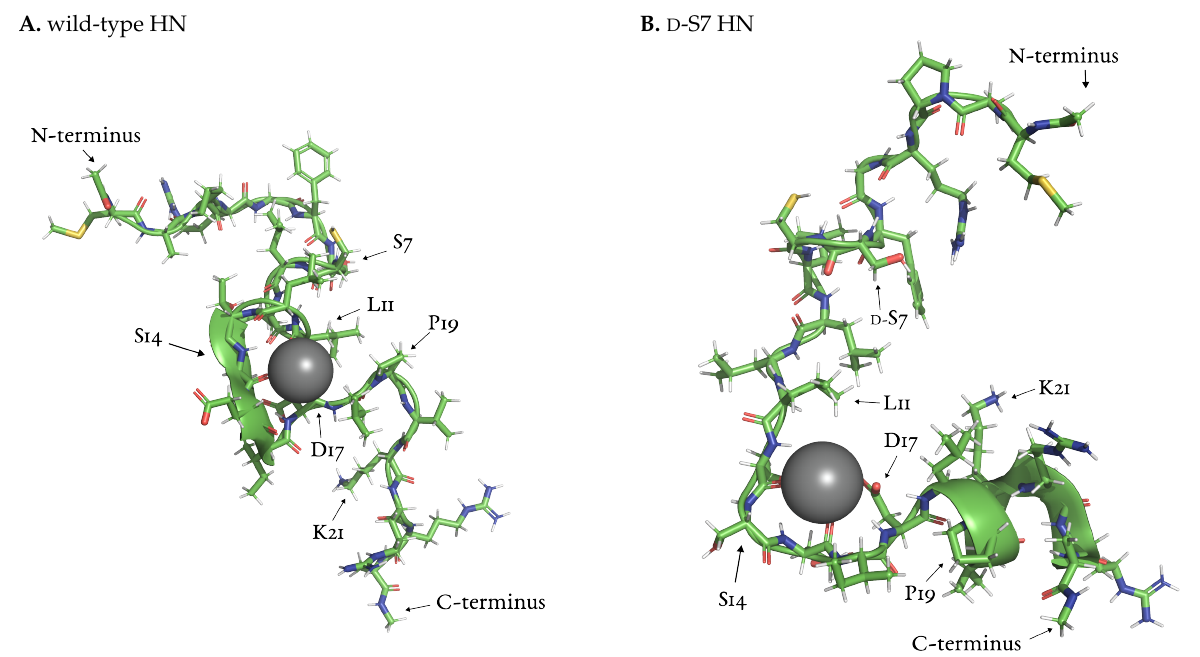
Figure 8. Sodium ion-stabilized structures found in wild-type ( A ) and D -dS7 ( B ) HN, both centered on S14. Snapshots taken at 297.14ns ( A ) and 306.08ns ( B ) of simulation